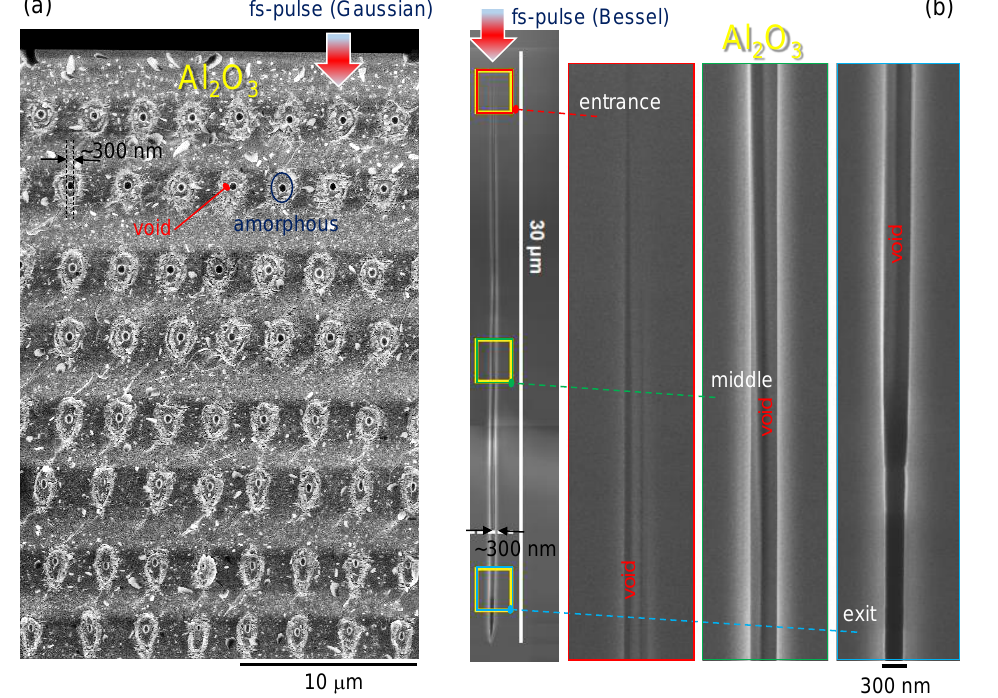
Figure 2. SEM side-view images of the voids made with ultra-short Gaussian [1,13] ( a ) and Bessel [8] ( b ) single pulses in sapphire. Focusing of the 800-nm/130-fs Gaussian pulses of ∼ 150 nJ of energy was carried out with an objective lens of numerical aperture NA = 1.3 and was stacked into a vertical plane of the void-structures [13]. This plane was used to split the sapphire sample for the side-view SEM observation. The voids made at larger depth were affected by spherical aberration, which reduced the void and elongated amorphous region. The 800-nm/140-fs, 2 µ J of energy, Bessel pulses were used to make cylindrical voids of a diameter of ∼ 300 nm revealed by focussed ion beam (FIB) milling